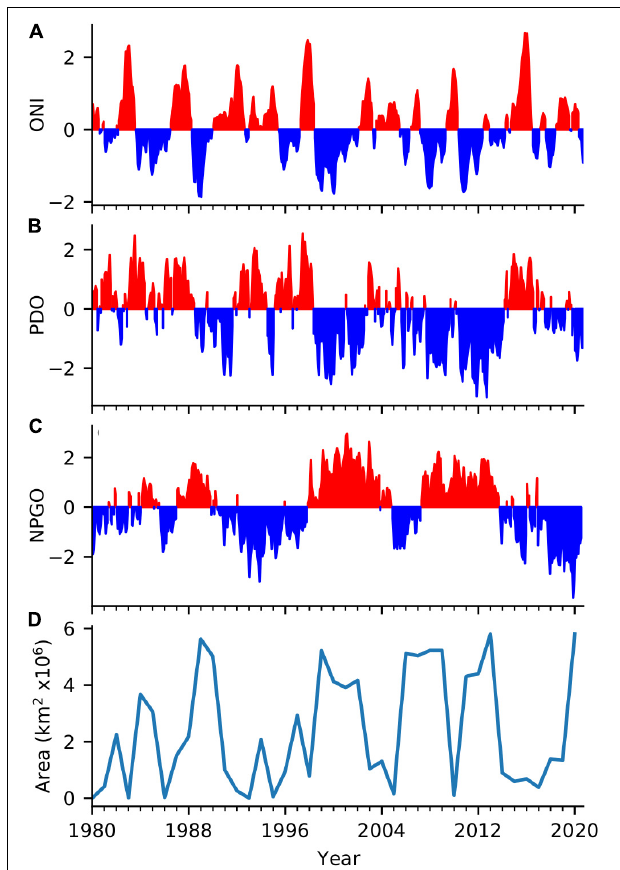
FIGURE 2 | Basin-scale indicators that are particularly relevant to the regional climate of the California Current: (A) Monthly values of the Oceanic Niño Index (ONI), (B) Monthly values of the Pacific Decadal Oscillation (PDO), (C) Monthly values of the North Pacific Gyre Oscillation (NPGO), and (D) Area of high atmospheric pressure of the North Pacific High averaged over January and February each year, as indicated by the areal extent of the 1020 hPa isobar located in the eastern North